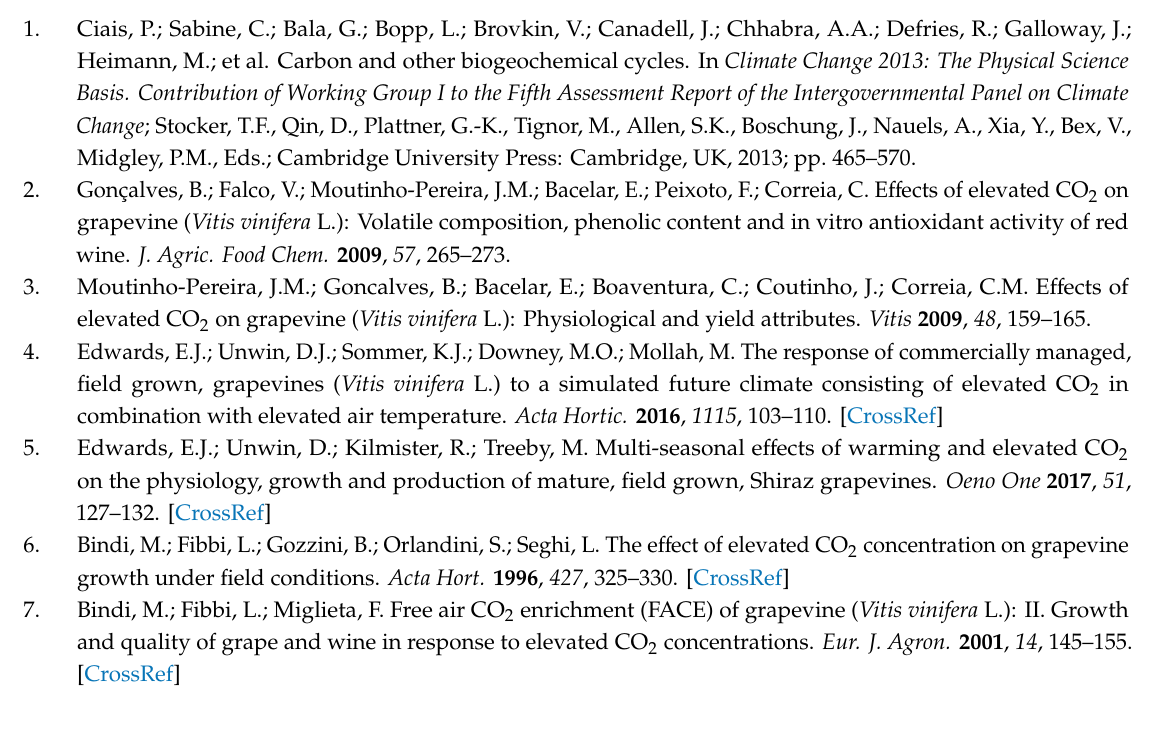
Figure S1: Regression between aCO 2 and eCO 2 values of single berry weight [g] for Riesling (a) and Cabernet Sauvignon (b) of the three single datasets of the three di ff erent seasons (2014, 2015, and 2016); Table S1: Posterior predicted probabilities for di ff erences in berry size categories between eCO 2 and aCO 2 being di ff erent from zero (P (di ff erence < 0) and P (di ff erence > 0)) for each year and both cultivars, Cabernet Sauvignon (CS) and Riesling (R), from Bayesian mixed-e ff ects adjacent category